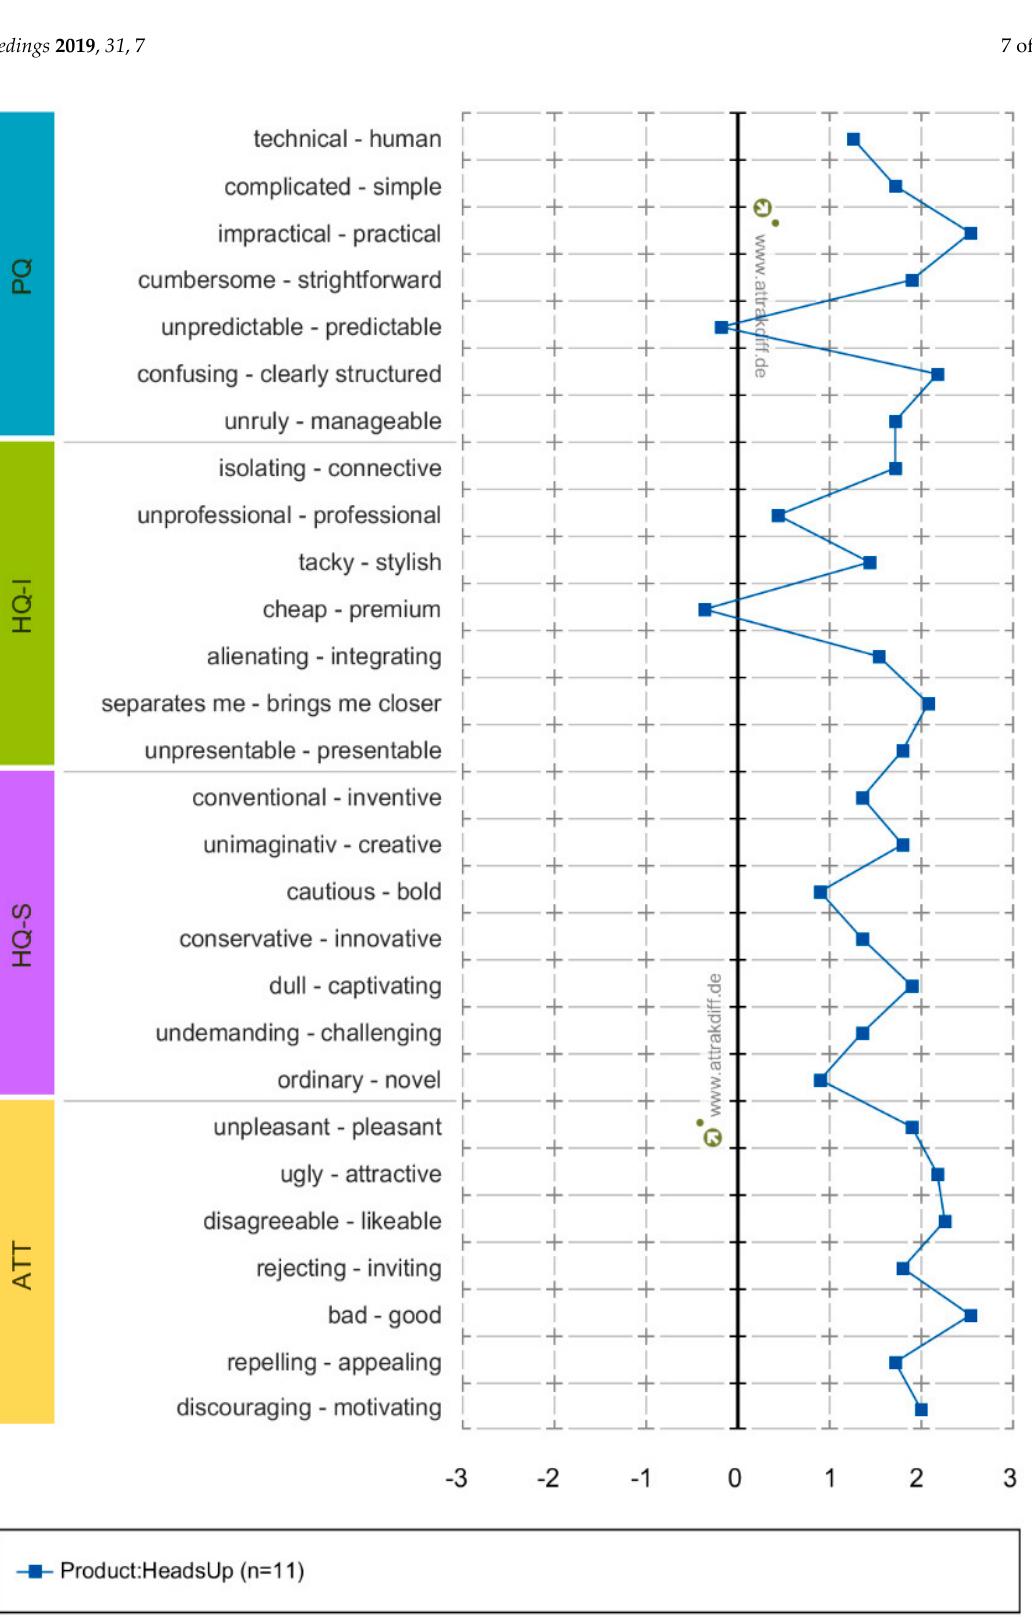
Figure 5. AttrakDiff